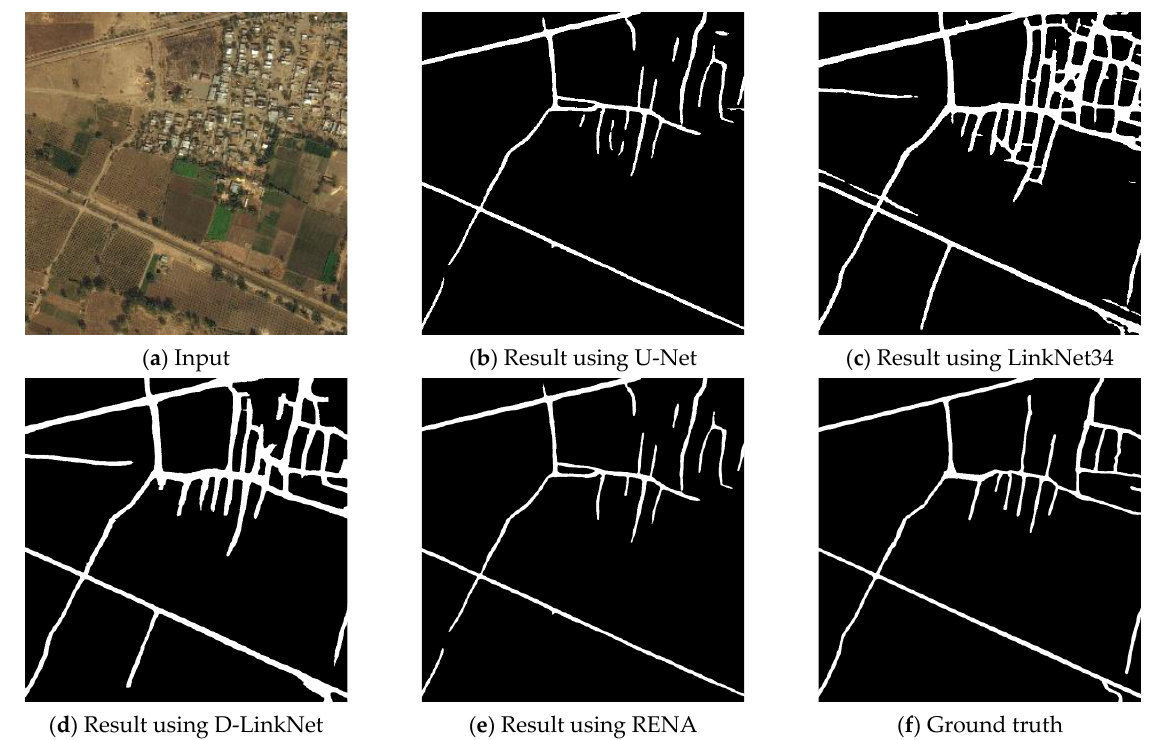
Figure 6. Visual evaluation results of the first group of dense road networks.